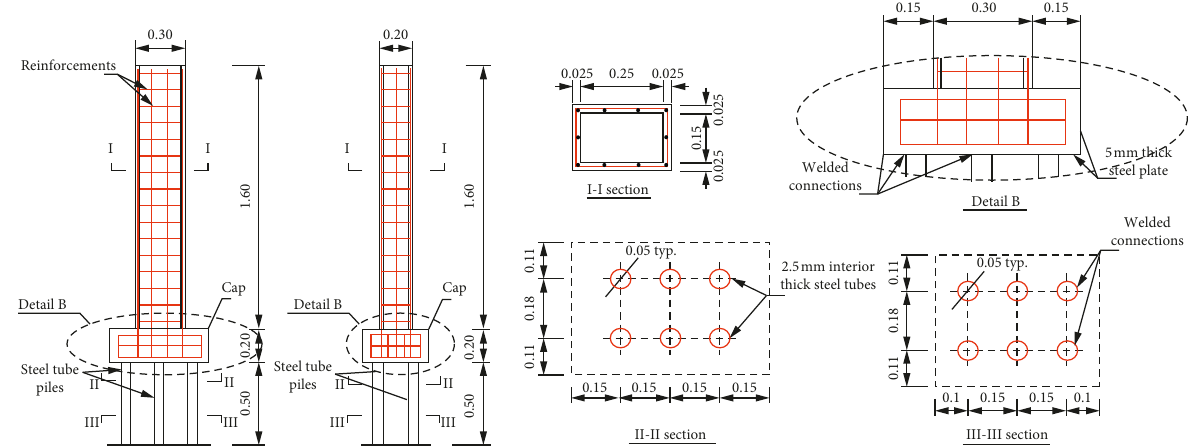
Figure 3: Dimensions and details of the hollow pier specimen; all dimensions are in meters unless otherwise